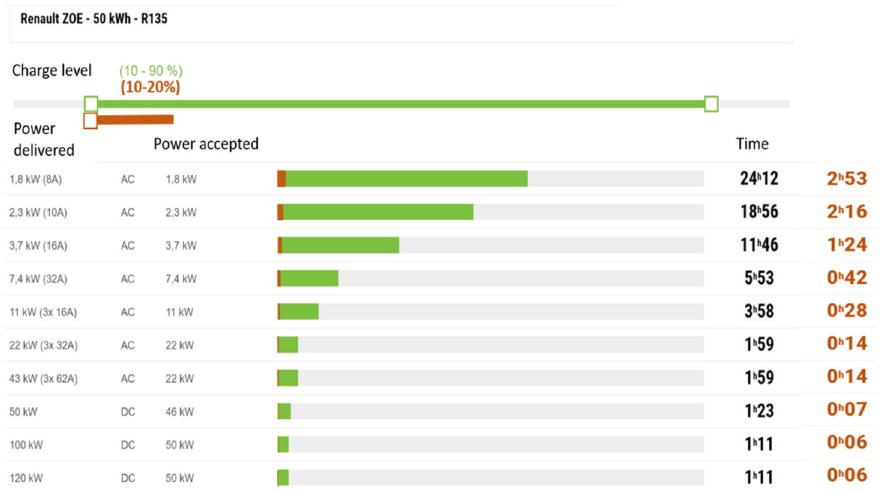
Figure 2. Required time for EV charging based on demand charge and delivered/accepted power.